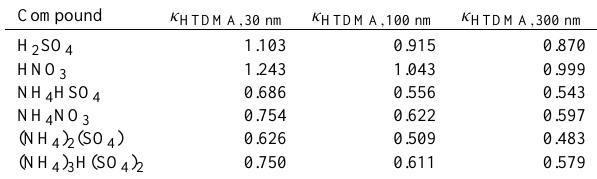
Table 1. κ -values for particles derived from ADDEM predictions of GF D0 , 90 for the inorganic compounds formed by the mixing